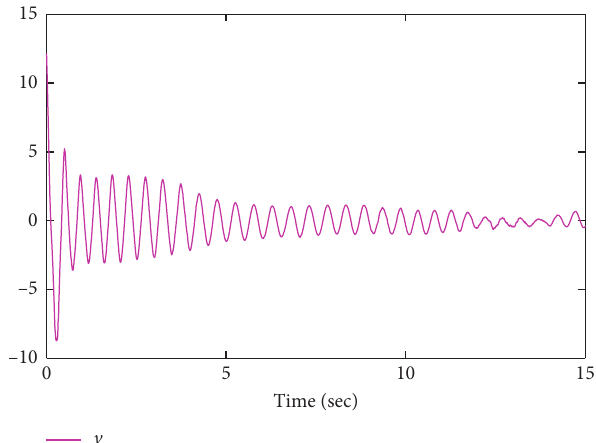
Figure 4: The response curves of state variable v .